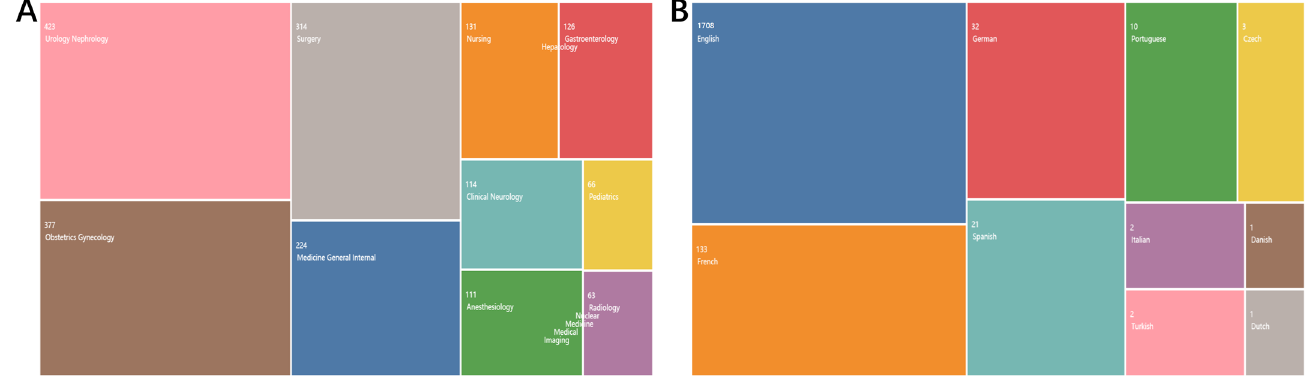
Figure 3. Research direction and language of published studies. ( A ) Research direction. ( B ) Language.